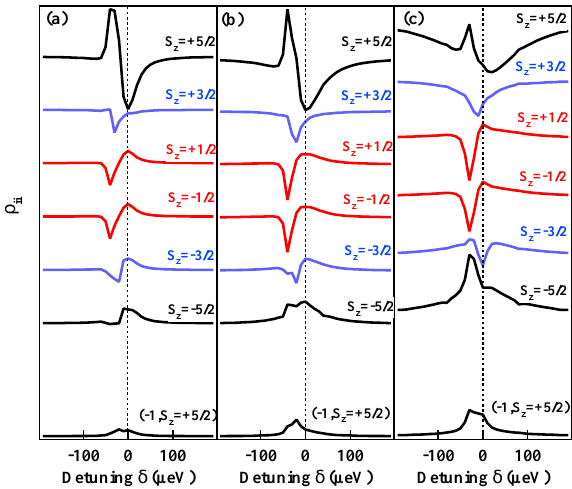
Figure 11: Calculated population of the six electronic spin states of a Mn versus the detuning δ of the CW control laser around the X-Mn state | J z = −1, S z = +5/2, I z ⟩ for different Rabi energies: (a) (cid:126) Ω (cid:126) Ω (cid:126) Ω R = 12.5 µ eV, (b) R = 25 µ eV, and (c) R = 50 µ eV. The relaxation times are τ Mn = 250 ns, τ r = 0.25 ns, τ relax = 60 ns, τ d = 100 ps and the Mn fine structure parameters D 0 = 7 µ eV and E = 0.35 µ